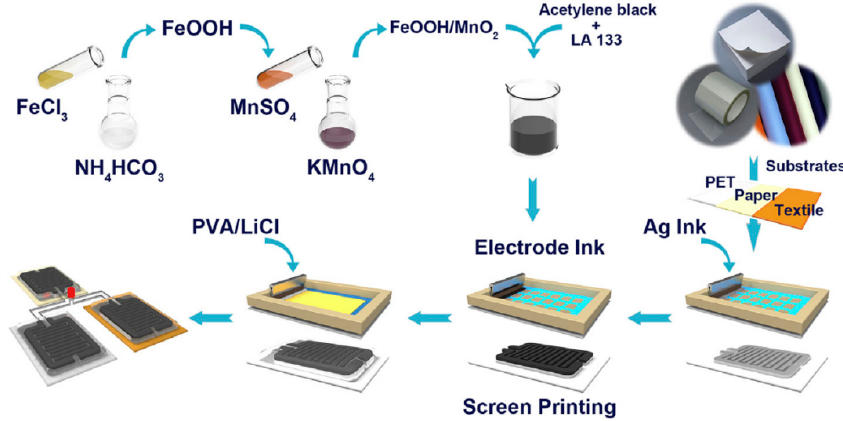
Figure 17. The preparation of MnO 2 composite ink and the schematic diagram of screen printing MnO 2 composite ink to prepare supercapacitor. Reproduced from [98], with permission from Elsevier, 2017.